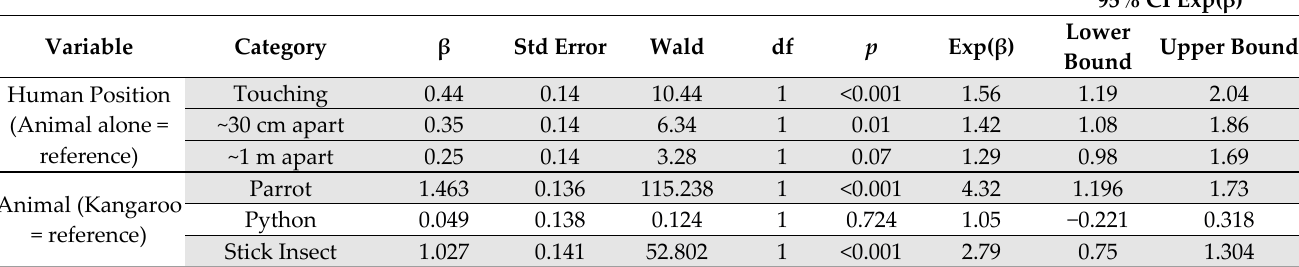
Table 5. Test statistics and effect sizes for variables in the final model to assess respondents’ agreement with the statement “the featured animal would make a good pet”. Parameter estimate ( β ), standard error (SE), Wald statistics (Wald), degrees of freedom (df), level of significance ( p ), cumulative odds ratio (Exp ( β )), and 95% confidence interval of the cumulative odds ratio (95% CI Exp ( β )) for variables disagree, slightly agree, and agree were coded as 1, 2, 3, 4, 5 .